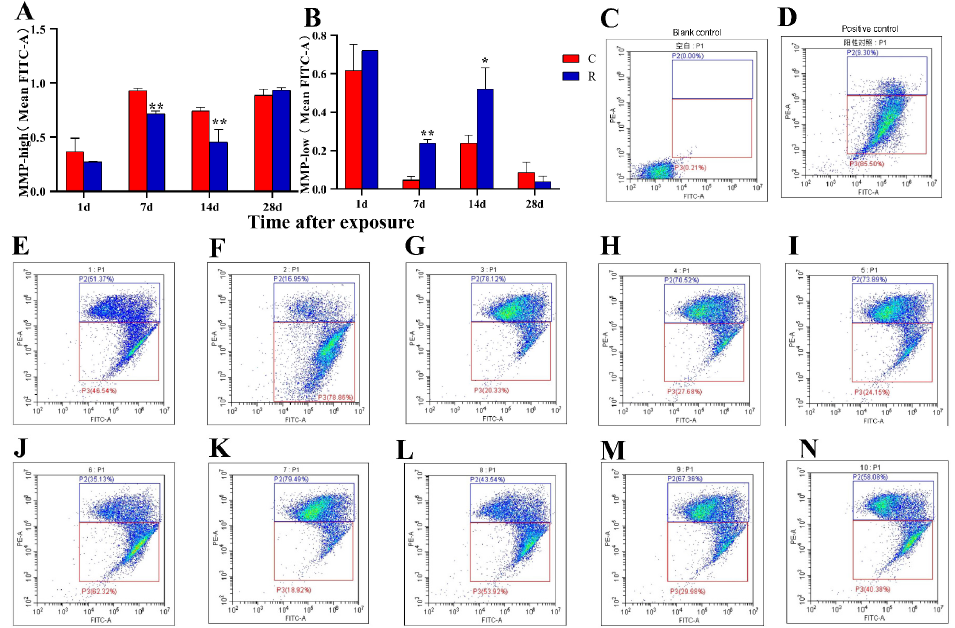
Figure 4. Changes in myocardial MMP in rats after S-band radiation. ( A ) Statistical analysis plot of MMP-high; ( B ) statistical analysis plot of MMP-low; ( C ) flow graph of blank control on Day 14; ( D ) flow graph of positive control on Day 14; ( E – I ) flow graphs of Group C on Day 14; ( J – N ) flow graphs of Group R on Day 14. Significance signs were classified according to p -value: * p < 0.05 and ** p <